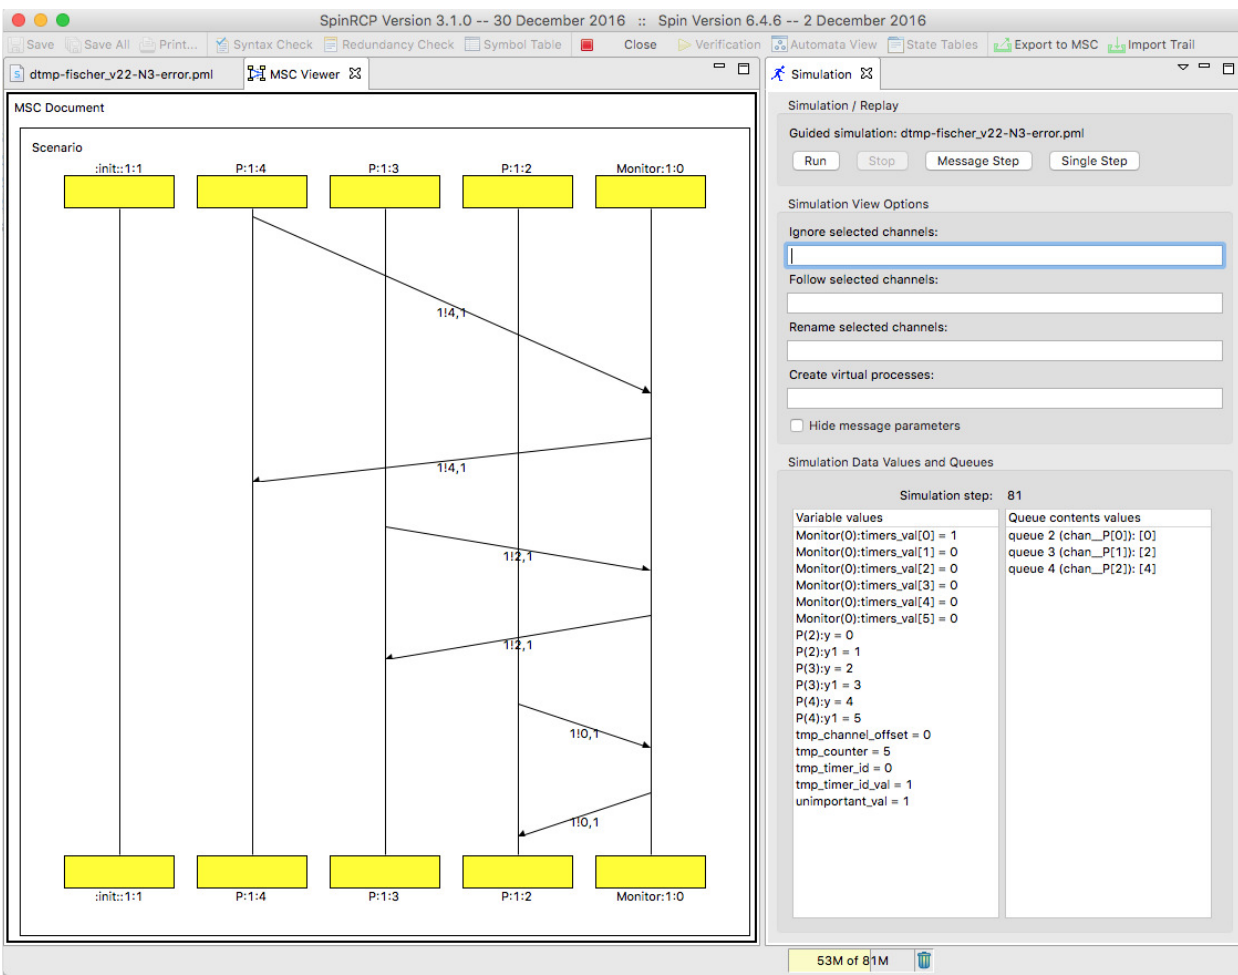
Figure 3. Formal verification with Spin and